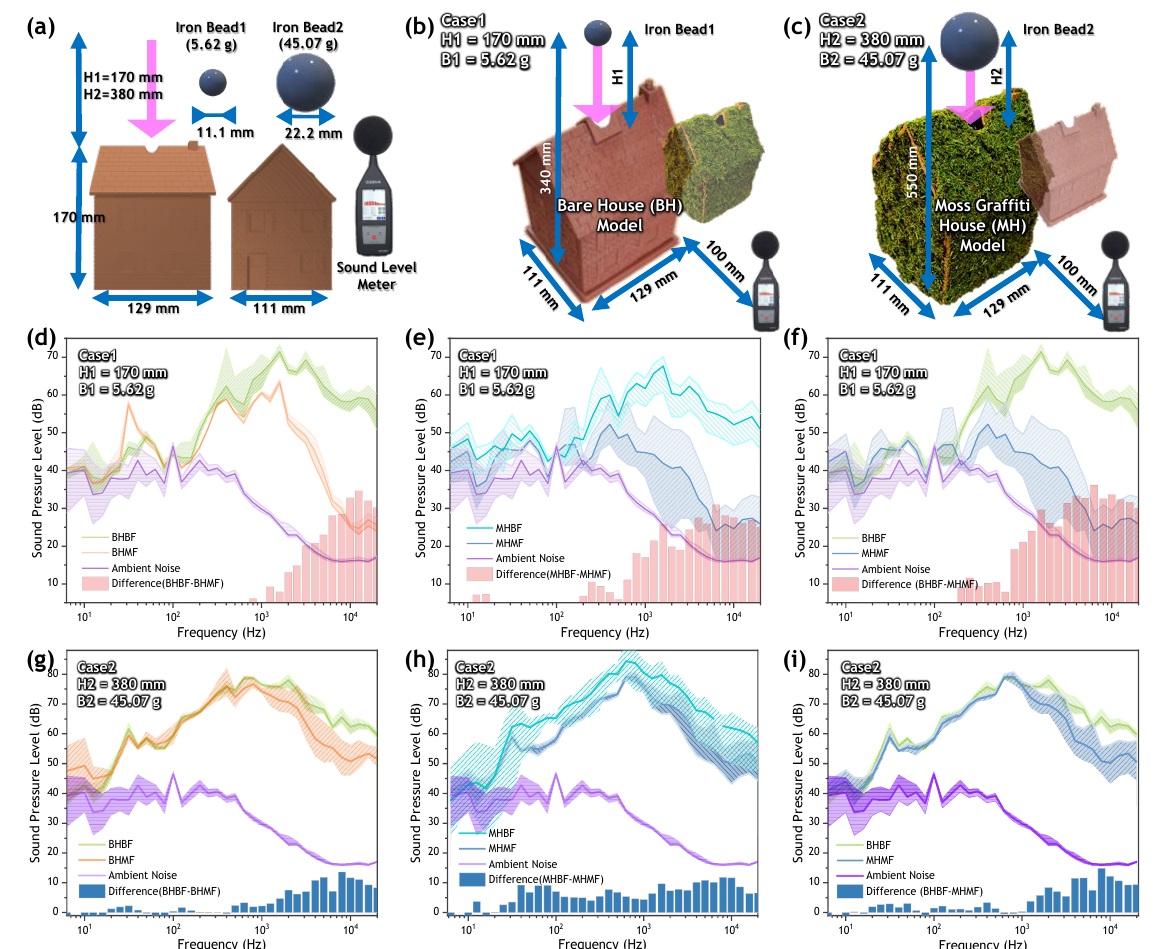
Figure 3. Results of s ound-absorption performance. ( a ) Schematic of sound-absorption coefficient (SAC) measurement using an impedance tube. ( b ) Sound-absorption coefficient of the samples. ( c ) Noise-reduction coefficient and acoustic activity of our samples. ( d ) Maximum SAC values and res- onant frequencies for each sample.